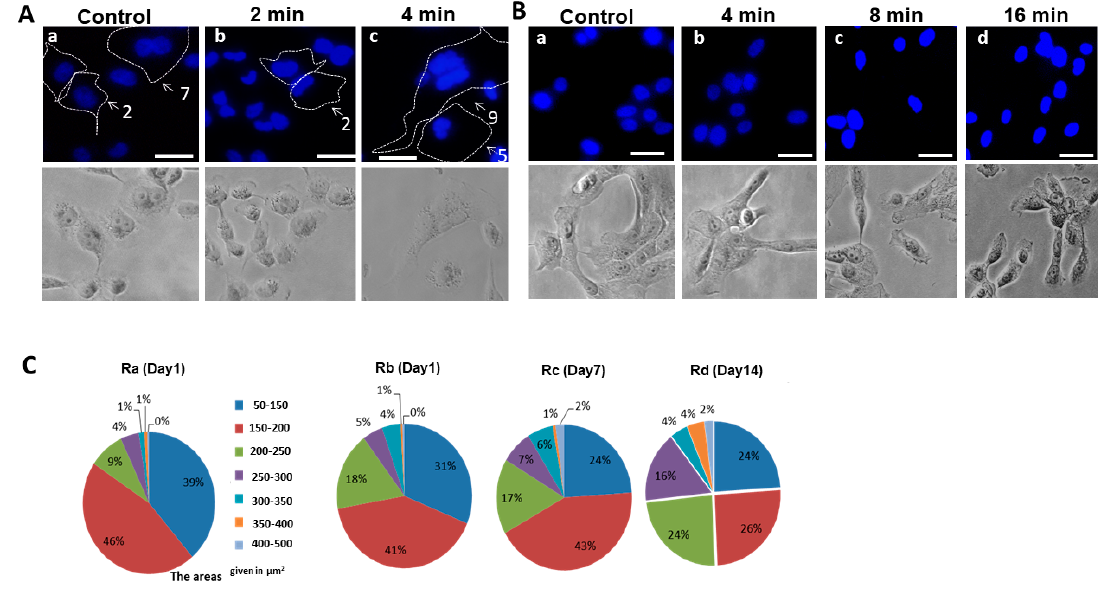
Figure 2. The distribution of the nuclei sizes and shapes in control and treated cells in response to MMW irradiation. ( A ) Representative images of H1299 nuclei morphology before and after irradiation. (a) Control cells’ nuclei show circle or oval morphology. Numbers indicate the subgroup classification as described in Table 1; (b) kidney-like nuclei appeared over long-term incubation (7–14 days) after irradiation for 2 min; and (c) multi-lobed and poly-nuclear cells appeared over long-term incubation (7–14 days) after irradiation for 4 min. Scale bars correspond to 10 μ m. ( B ) Representative images of MCF-10A nuclei morphology before and after irradiation. (a) Control cells’ nuclei show circle or oval morphology; (b–d) nuclei shape remains same over long-term incubation (7–14 days) after irradiation for 4, 8, and 16 min. Scale bars correspond to 10 μ m. ( C ) Control H1299 cell population distribution by area size of nuclei in the cells. The areas indicated are given in μ m 2 . Analysis of nuclei distribution in the control groups consisted of four dishes (Ra–d). The number of cells were measured in each group for each day of observation was 400–475. Each experiment involved four repeats.